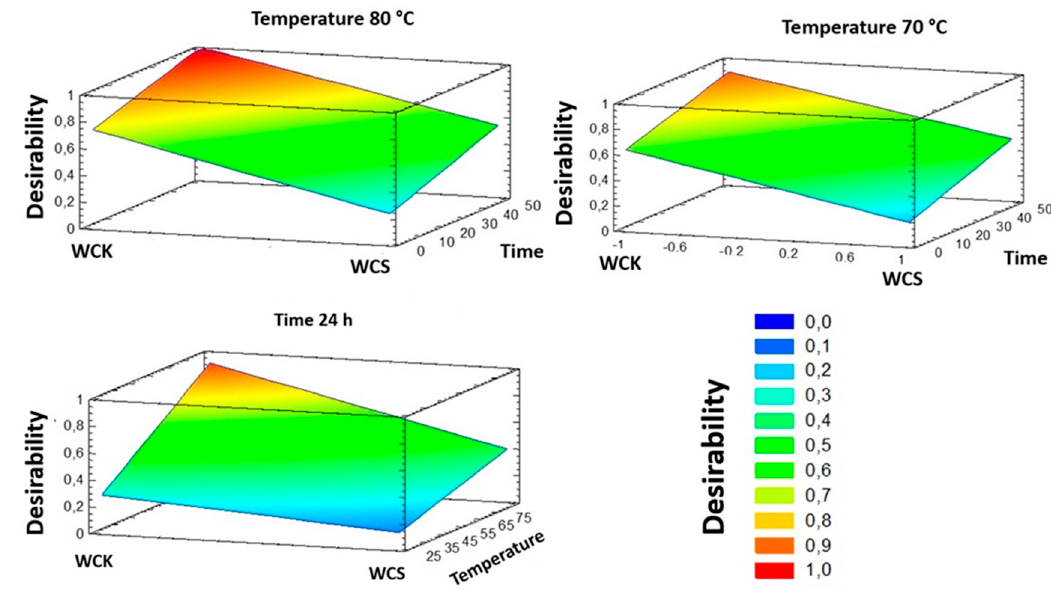
Figure 10. Estimated response surface for cellulose produced through the WCK and WCS processes. Temperature and time are expressed in °C and h, respectively.